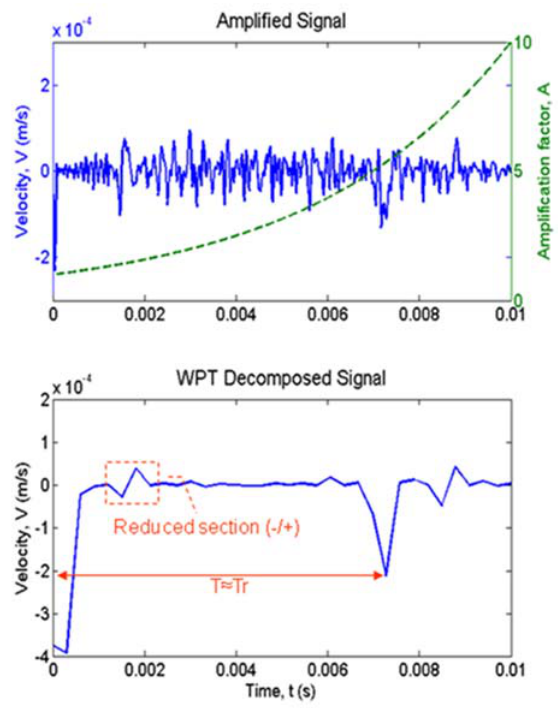
Figure 17. Amplified and WPT decomposed velocity signal for case f dataset 6 (crack).